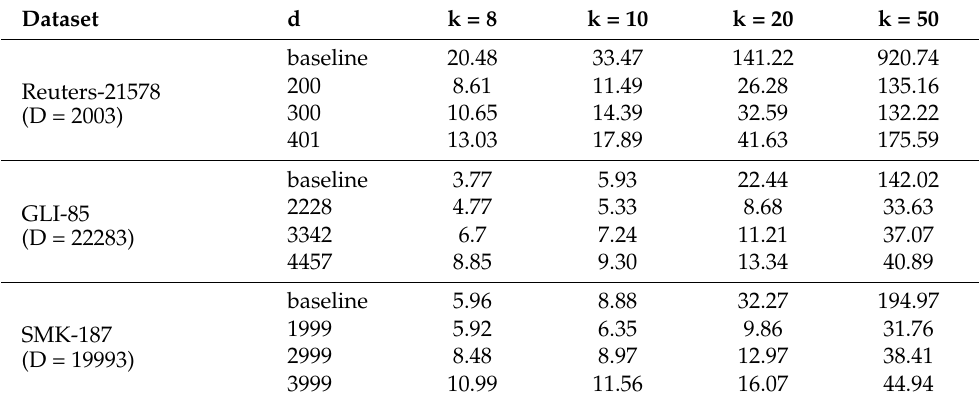
Table 2. Training time